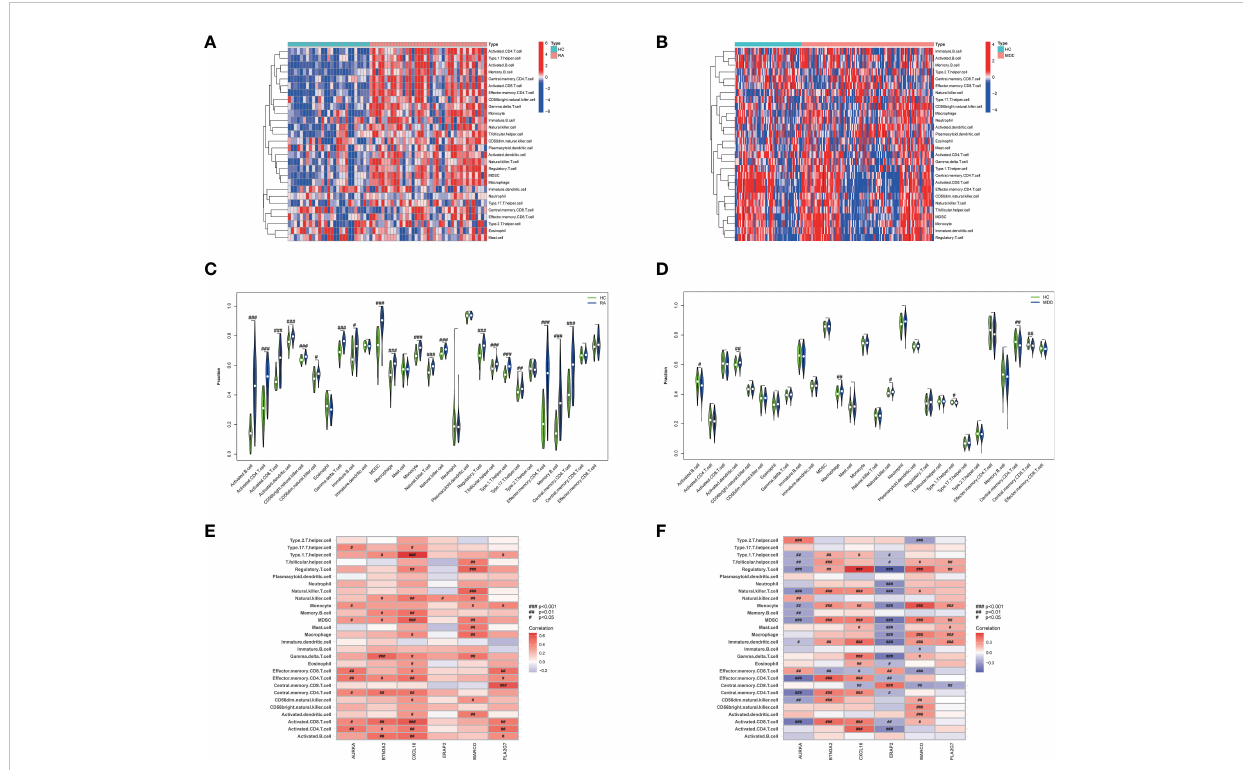
FIGURE 8 The 28 immune cells and their correlation with the 6 common core genes in RA and MDD. (A) Heatmap of 28 immune cell expression scores in RA. (B) Heatmap of 28 immune cell expression scores in MDD. (C) Comparison of 28 immune cells in samples with HC and RA by Fraction. (D) Comparison of 28 immune cells in samples with HC and MDD by Fraction. (E) Spearman correlation analysis of the 6 common core genes and 28 immune cells in RA. (F) Spearman correlation analysis of the 6 common core genes and 28 immune cells in MDD. # p < 0.05; ## p < 0.01; ### p < 0.001.